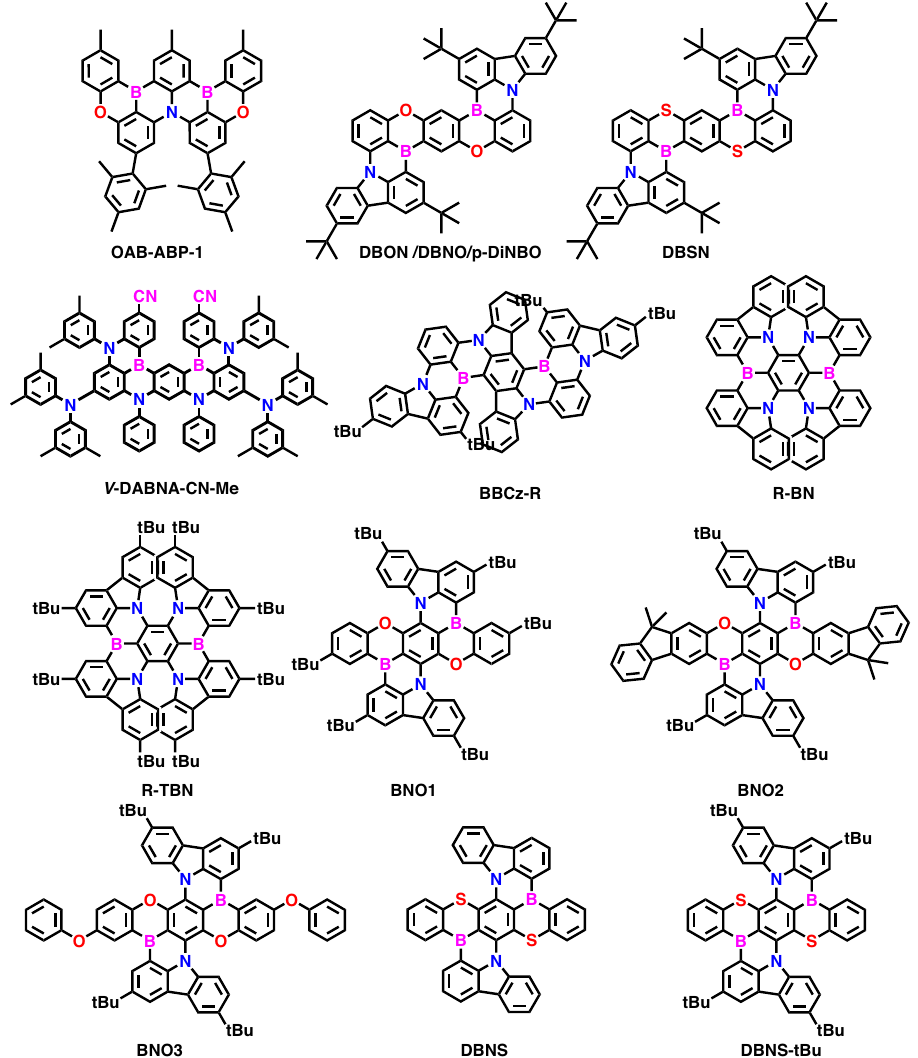
Fig. 5 Chemical structures of green to deep red MR-TADF. Molecular structures of the green to deep red DB-MR-TADF